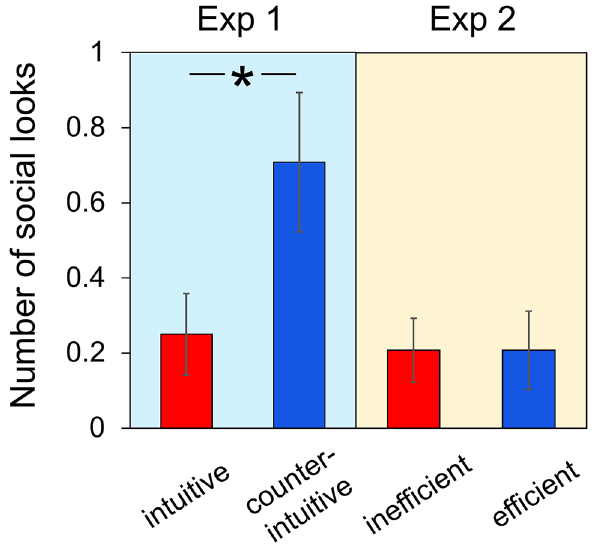
Figure 2. Number of social looks in the familiarization phase of Experiment 1 and 2. Intuitive = intuitive events: physically intuitive and inefficient goal-achievement events, counterintuitive = physically counterintuitive and efficient goal-achievement events, inefficient = inefficient and physically intuitive goal-achievement events, efficient = efficient and physically intuitive goal-achievement events. Error bars present the standard errors (*p < 0.05).